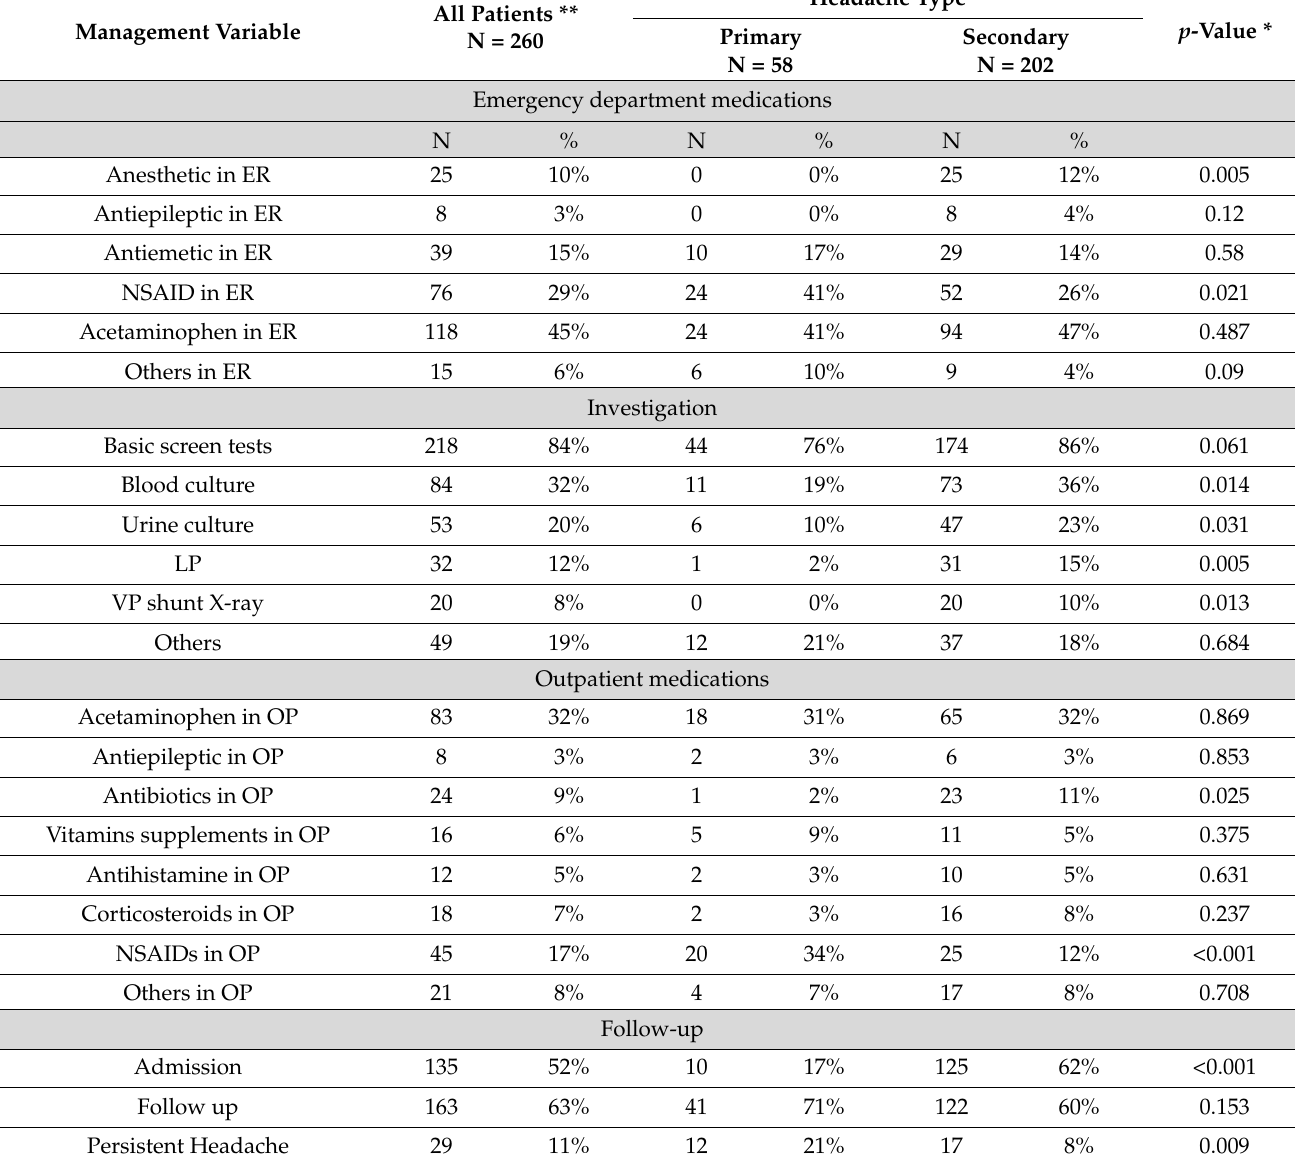
Table 4. Management stratified by type of